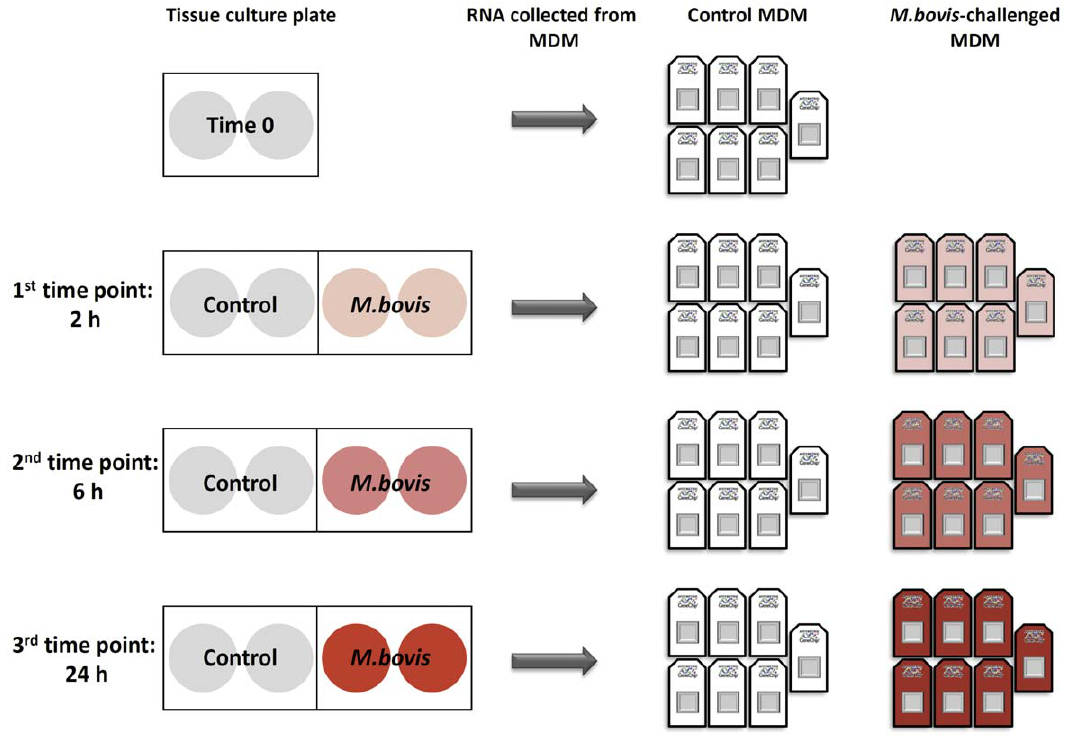
Figure 1. Schematic depicting the experimental design used in the current study. MDM were cultured in 24-well tissue culture plates (2 6 10 5 cells per well) and challenged with M. bovis (MOI 2:1). RNA was extracted from M.bovis -challenged and non-challenged control MDM at three time points post-challenge: 2 hours, 6 hours and 24 hours. In addition, RNA was extracted from a 0 hour non-challenged control to assess potential non-experimental changes in gene expression. The MDM lysates from replicate tissue culture wells (shaded) were pooled for RNA extraction. Global gene expression for the control and M. bovis -challenged MDM was analysed using the Affymetrix H GeneChip H Bovine Genome Array.